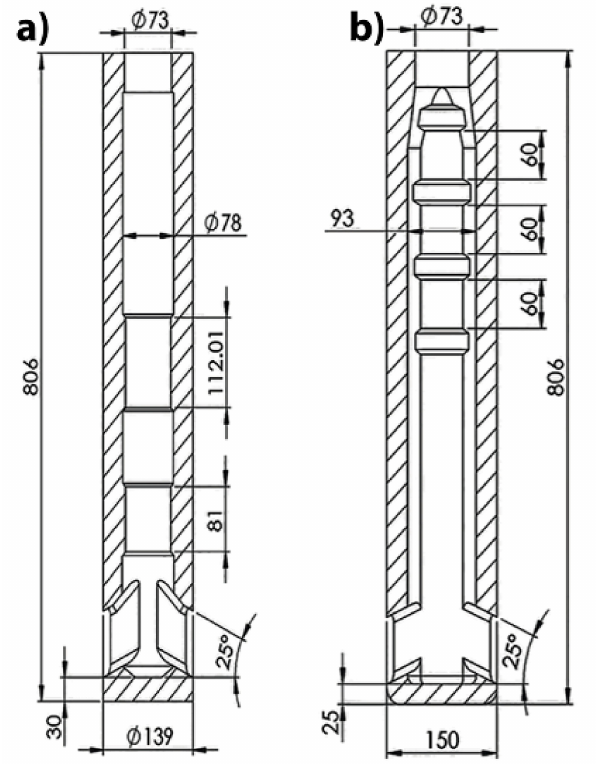
Figure 4. Replicas of nozzles A and B, including the clogging and the resin cores used to pour the harden rubber to print its surface topography. ( a ) Nozzle A. ( b ) Nozzle B.